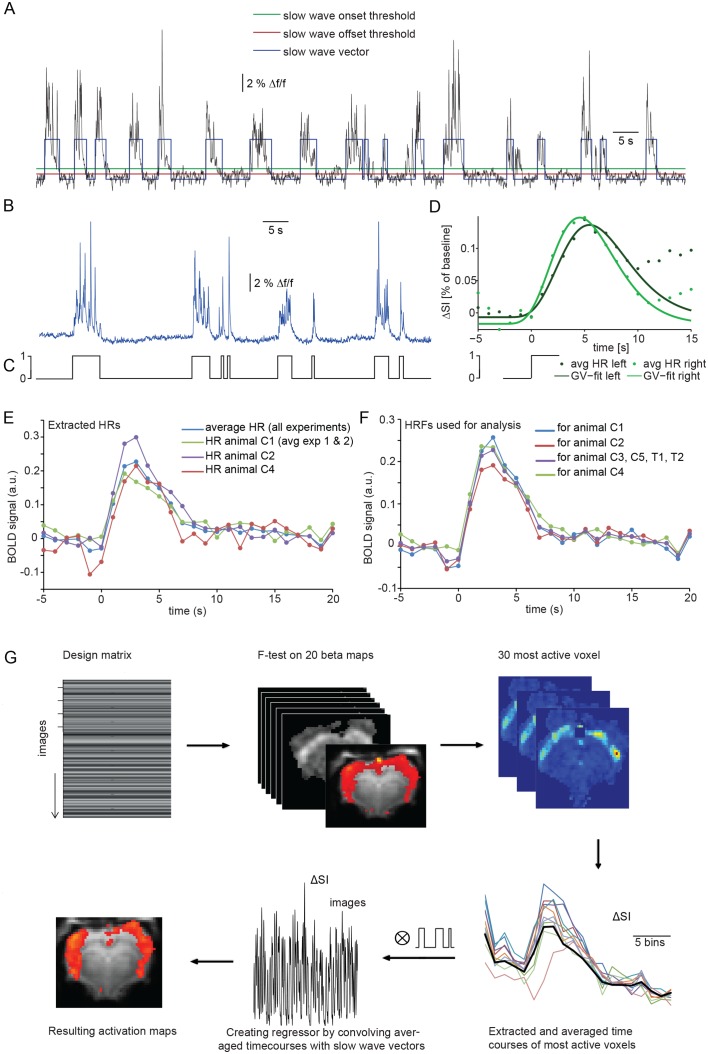
Identifying a BOLD response upon slow wave events detected in cortical calcium recordings.(A) Onset and termination thresholds based on EMA filters detect slow wave events in a calcium trace recorded in the MR scanner and can be used to create a slow wave vector. (B,C) The binarized slow wave vector (C) containing the precise timing of the slow calcium wave events (B) can be used as an event array for subsequent fMRI analysis. (D) Averaged BOLD signal in cortical ROIs in both hemispheres of an individual experiment upon the onset of slow calcium wave events, fitted with a gamma variate (GV). Note, that due to subsequent slow calcium wave events within the time frame of the respective BOLD response (see A,B), the raw signal does not decay to baseline levels. (E) Extracted hemodynamic responses (HRs) with finite impulse response (FIR) methods. Intra- and interindividual timecourses show almost identical signal characteristics. (F) Individual HRs were averaged and used as HRF for subsequent fMRI analysis (for animal C1 HRs from animal C2 and animal C3 were averaged; for animal C2 HRs from animal C1 and animal C3; for animal C3 HRs from animal C1 and C2; for animal C4 HRs from animal C1, C2; for animal C3, C5, T1 and T2 HRs from animal C1, C2 and C4 were averaged). (G) Flow chart of fMRI analysis procedure starting with the design matrix, defined by the FIR basis function set and the spontaneous calcium wave as event.